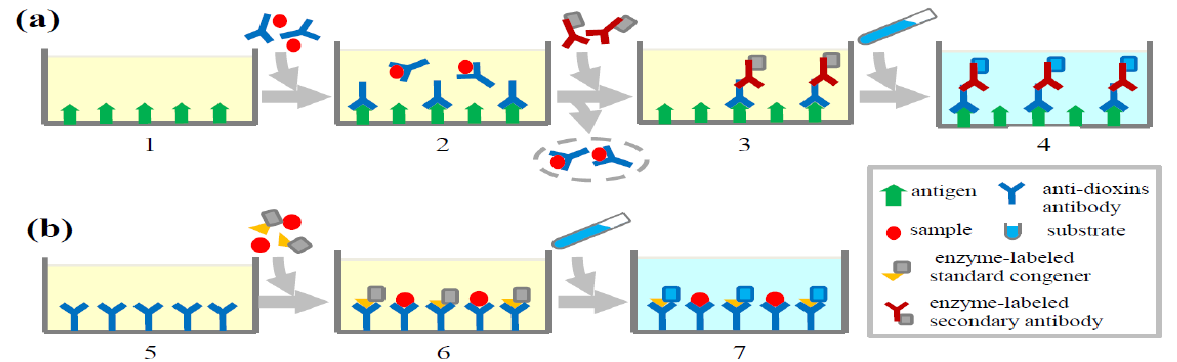
Figure 1. Schematic diagram for experimental procedure of indirect and direct competitive ELISA for detecting dioxins. ( a ) For an indirect competitive ELISA assay, a microplate is coated with appropriate antigens (1). Samples and anti-dioxin antibodies (Abs) are added in to the microplate. Antigens compete with dioxins in the test sample for binding to the Ab (2). After incubation, soluble molecules are washed away. Secondary antibody labeled with enzyme is added and reacts with the immobilized anti-dioxin Abs (3). Substrates are added to detect the immobilized Ab (4). ( b ) For a competitive ELISA assay, a microplate is coated with anti-dioxin Ab (5). After incubation, soluble Abs are removed by washing. Samples and enzyme-labeled standard congener are added which compete for binding to the anti-dioxin Abs. After incubation, soluble molecules are washed away (6). Substrates are added to detect immobilized standard congener